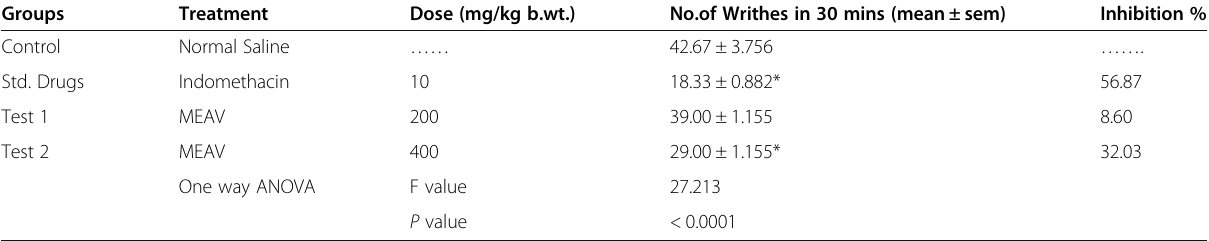
Table 4 Effect of methanol extract of A. vulgaris leaves extracts on acetic acid-induced writhing behavior in mice Groups Treatment Dose (mg/kg